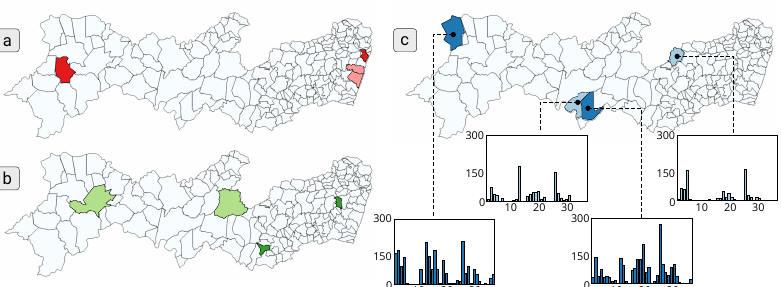
Figure 3. Variables considered in the comparison distribution questions of the user study: ( a ) distance between regions, ( b ) region size, ( c ) data variance. Examples were manually selected to compare these factors. In each scenario, we paired regions with the same shade of color (dark–dark, light–light).